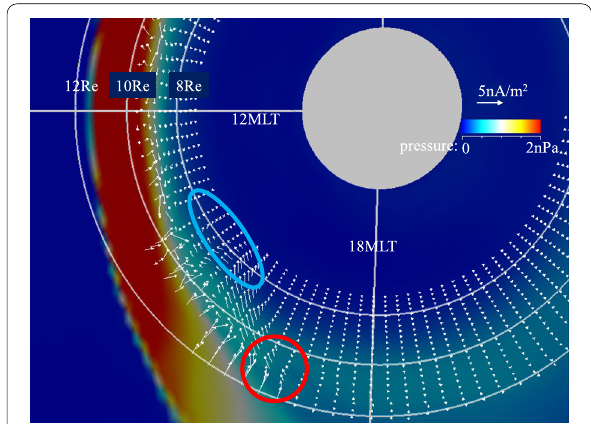
Fig. 7 Vectors of the inertia current ( J i ) in the post-noon sector of the equatorial plane at 5.5 min. The pressure distribution in the equatorial plane is shown with color shading. See Fig. 6 caption for descriptions of the red circle and blue ellipse